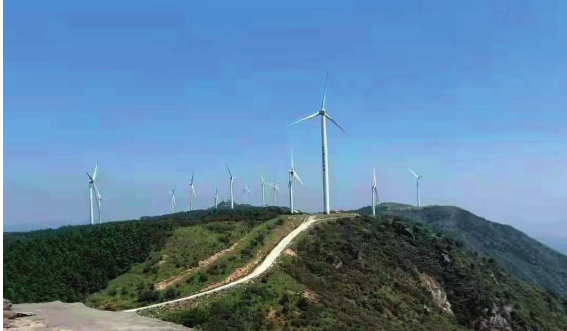
Figure 1: Wind driven generator at